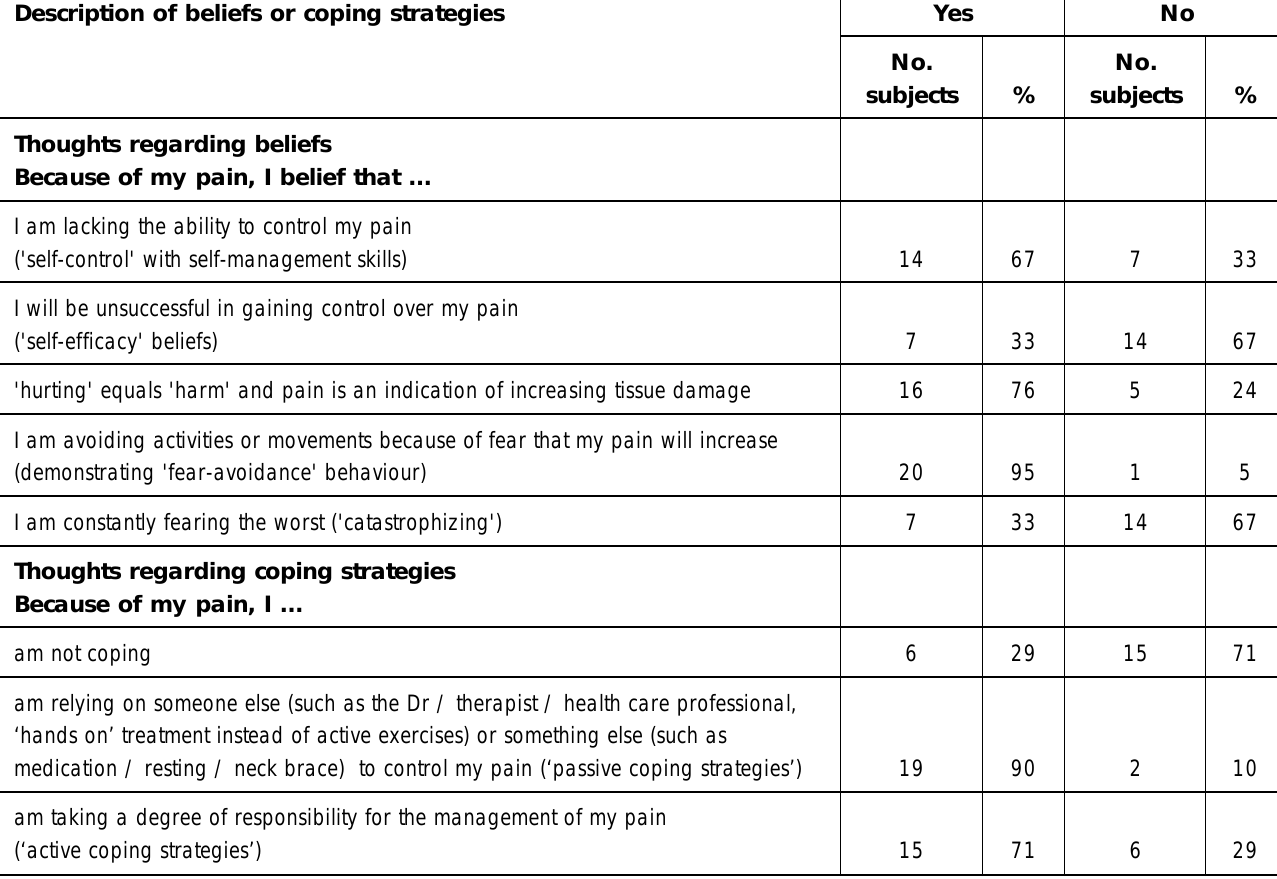
Table 4: The cognitive dimension obtained from responses to self-designed questions on thoughts regarding beliefs and coping strategies by 21